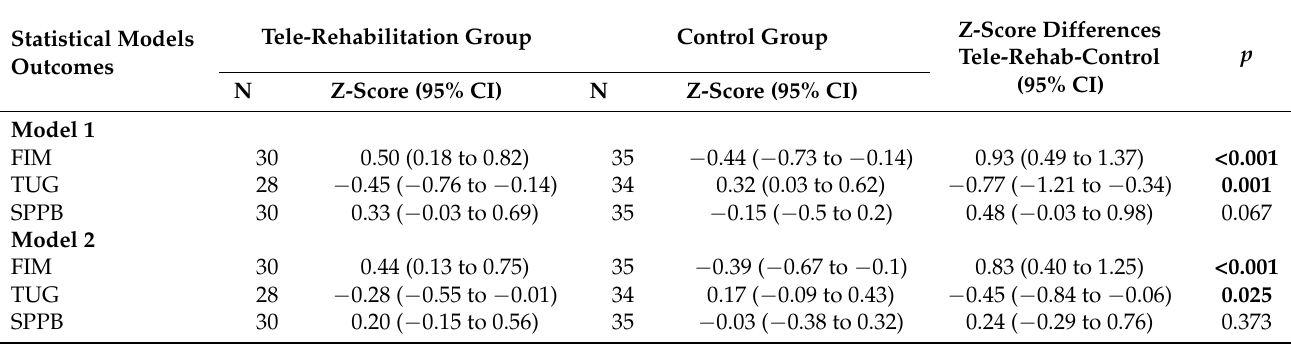
Table 2. Intervention effects of the ActiveHip